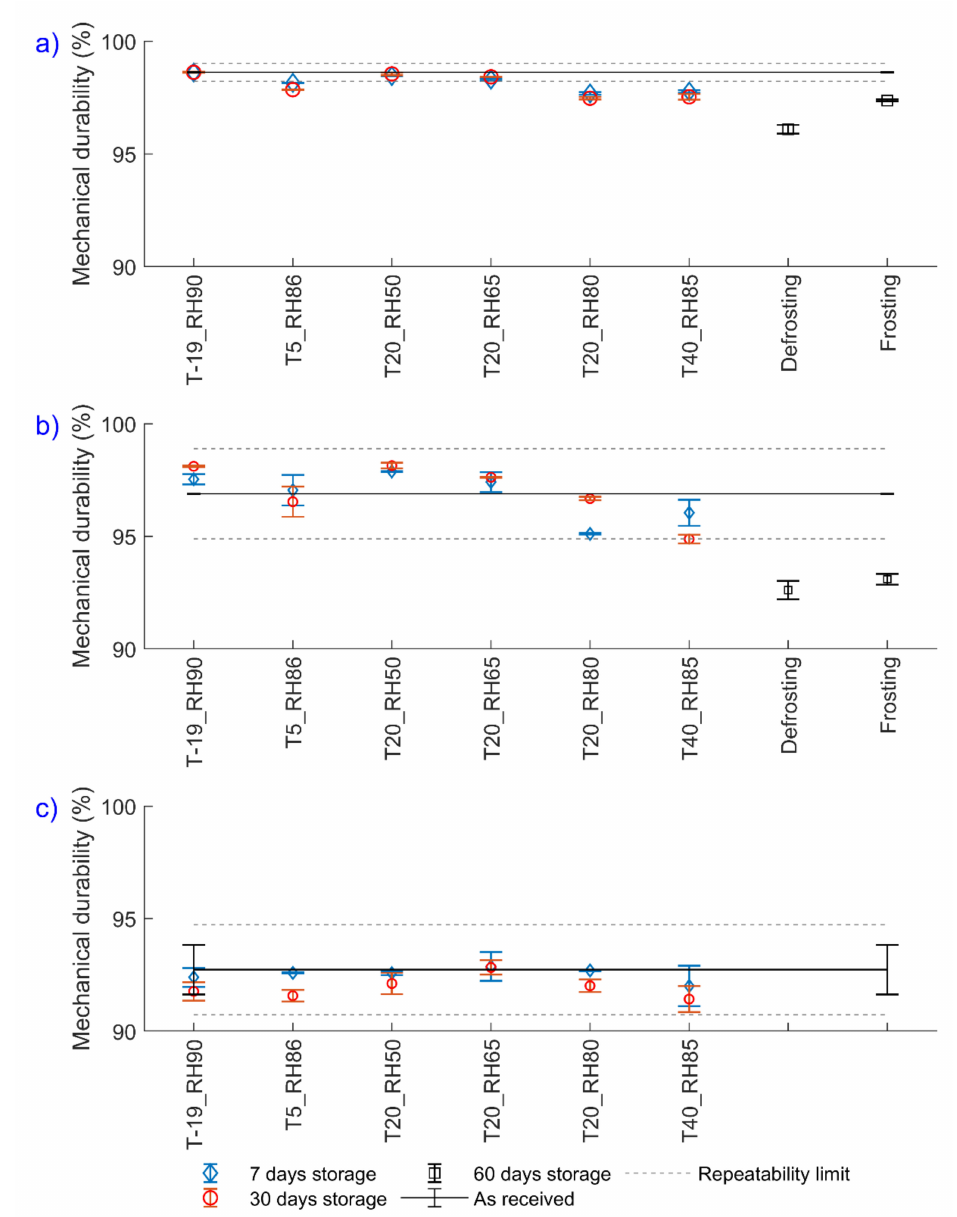
Figure 5. Mechanical durability values of di ff erent pellets after storage for ( a ) brown, ( b ) white, and ( c ) torrefied pellets. The error bars show the standard deviations and the solid lines show the as-received mechanical